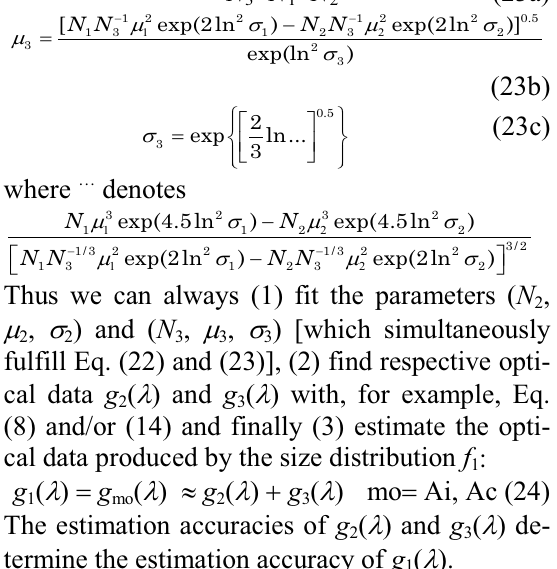
Fig. 1c. analytical expressions (dotted lines) and with